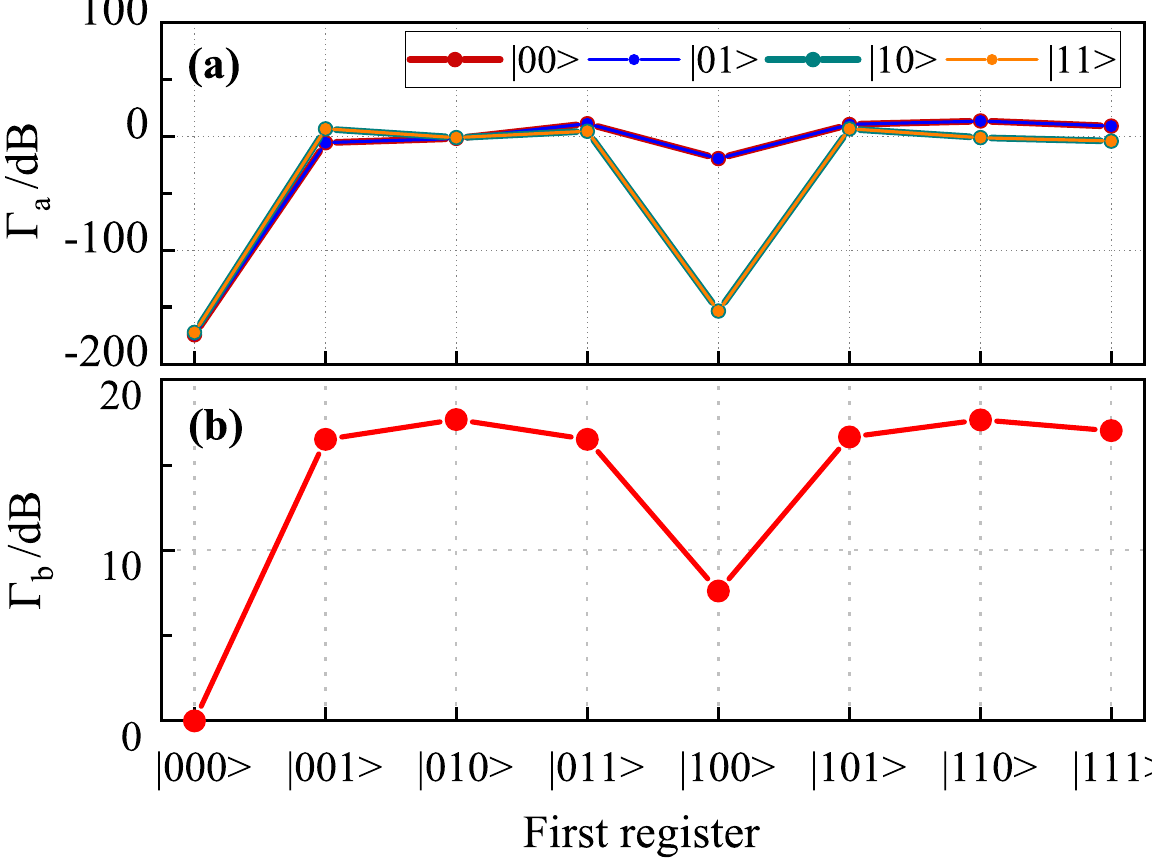
(cid:78) 3 | Figure 5. The results of benchmarking with error metrics Γ a and Γ b . ( a ) Γ a uses | 0 (cid:105) 00 (cid:105) (red line), | 0 (cid:105) (cid:78) 3 | 01 (cid:105) (blue line), | 0 (cid:105) (cid:78) 3 | 10 (cid:105) (green line), | 0 (cid:105) (cid:78) 3 | 11 (cid:105) (purple line) as tools to benchmark these with (cid:78) 3 | different states in the first register, respectively. ( b ) Γ b uses the state | 0 (cid:105) 00 (cid:105) , which combines the (cid:78) 3 | (cid:78) 3 | (cid:78) 3 | position of zero value in | 0 (cid:105) 01 (cid:105) , | 0 (cid:105) 10 (cid:105) and | 0 (cid:105) 11 (cid:105) together, and benchmark these states with the difference in the first